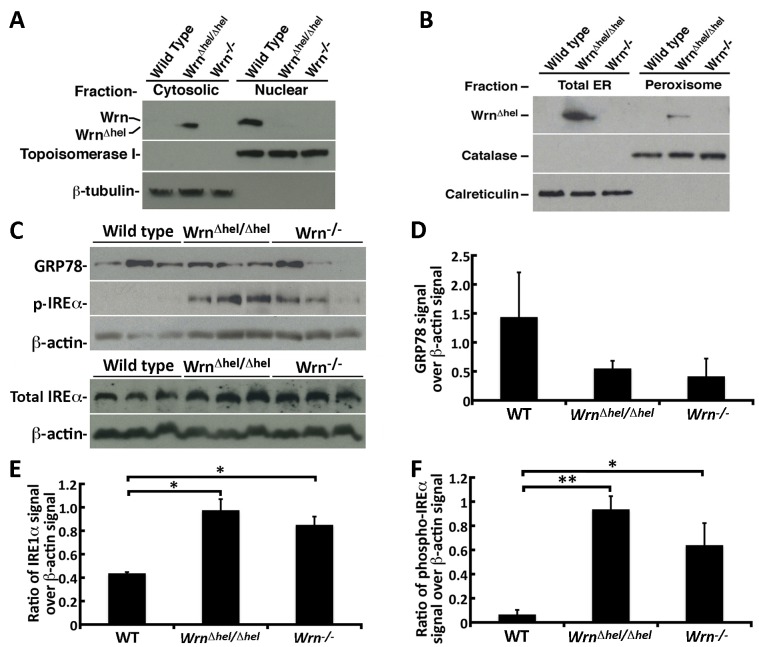
Localization of the WT and mutant Wrn proteins in different subcellular fractions.(A) Example of western blots showing the presence of the Wrn WT protein in the nuclear fraction and the presence of the WrnΔhel mutant protein mainly in the cytosolic fraction. Fractionations were performed on WT, Wrn
Δhel/Δhel, and Wrn
-/- MEFs. Topoisomerase I and β-tubulin are nuclear and cytoplasmic markers, respectively. As expected the molecular weight of the WrnΔhel mutant protein was lower than the Wrn WT protein. No band was detected in Wrn
-/- MEFs fractions with the anti-Wrn polyclonal antibody. (B) Example of western blots showing only the presence of the WrnΔhel mutant protein in total ER and the peroxisomal fractions. Fractionations were performed on WT, Wrn
Δhel/Δhel, and Wrn
-/- liver tissues. Catalase and calreticulin are used as peroxisomal and ER specific markers. This experiment was repeated three times. (C) Protein levels of GRP78, phosphorylated IREα, and β-actin (top panels) and of total IREα, and β-actin (bottom panels) in the spleen of three animals of each genotype. (D) Ratio of GRP78 signal over β-actin signal from western blots. (E) Ratio of IREα over β-actin signal from western blots. (F) Ratio of phosphorylated IREα signal over β-actin signal from western blots. Experiments were performed in triplicates. Bars in all histograms represent SEM. Tukey post ANOVA test P-values are shown (*P < 0.05 and **P < 0.01).